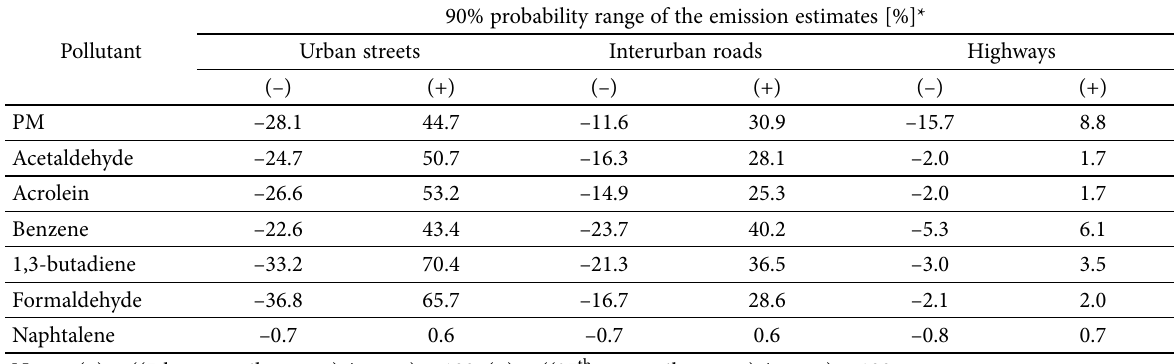
Table 3. Results of the uncertainties in the emission rates (hot+cold) for the different types of roads